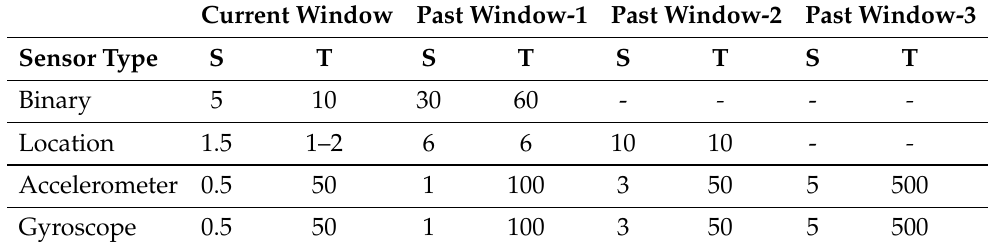
Table 2. Sliding window sizes and the total quantity of data gathered by each type of sensor. S = Duration in seconds, T = Total generated data in the